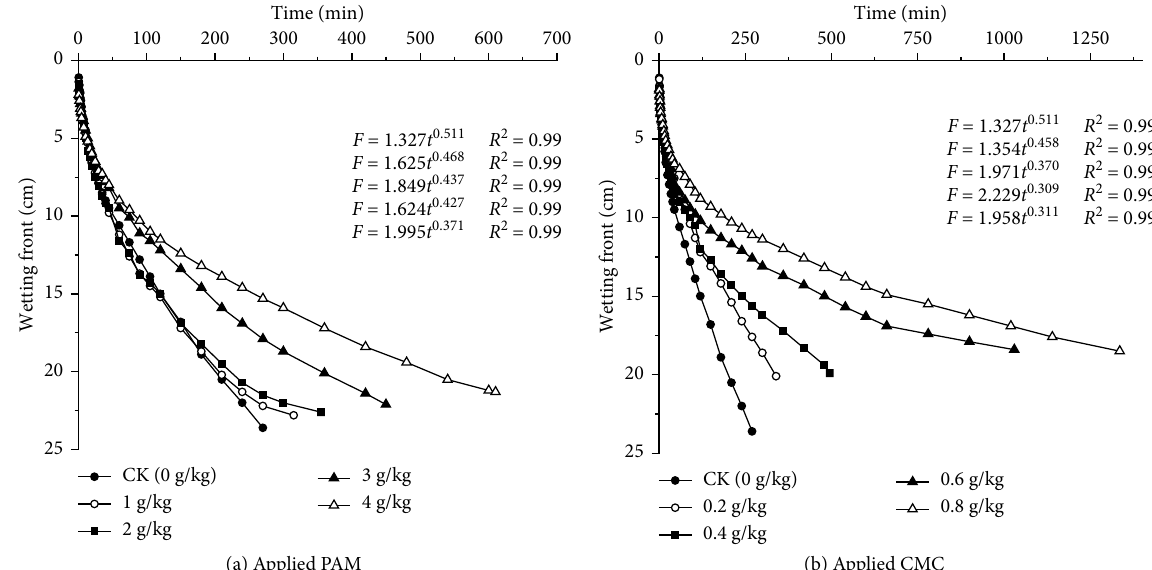
Figure 2: Effects of different application rates for (a) PAM and (b) CMC on dynamic changes of wetting front in sandy loam soils. Table 1: Influence of PAM and CMC application rates on infiltration characteristics.